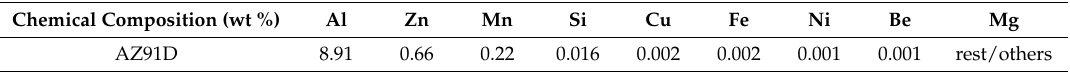
Table 1. The chemical composition of the workpiece AZ91D alloy.